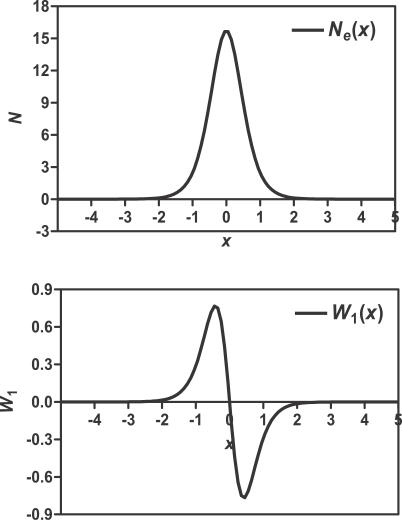
Sensing Window of the Polarized Peak That Detects the Position Dependence of a ParameterThe velocity of the polarized peak responding to a parameter gradient is determined by
W
1(x)ɛGa(x) dx, where ɛGa(x) represents the position dependence of the parameter. Here we can regard W
1(x) as a sensing window. The upper panel shows the profile of the polarized peak,
(x); the lower panel indicates W
1(x).